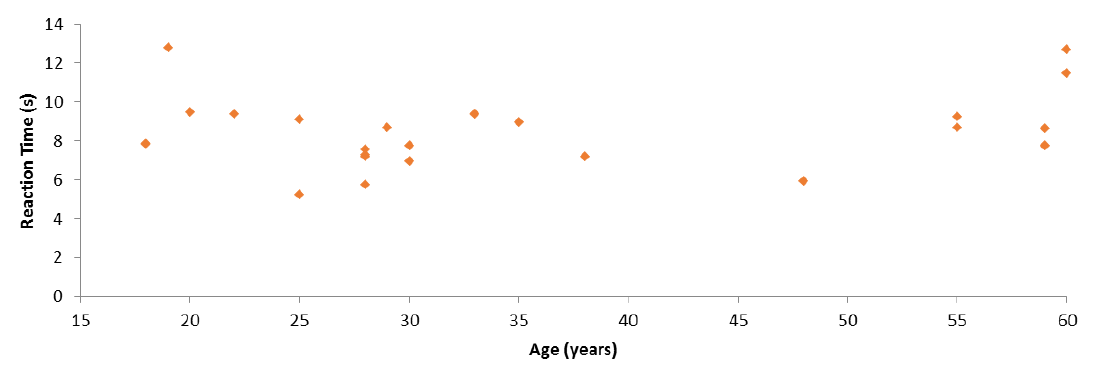
Figure 12. Comparison between the reaction time in the smart cupboard test and participant